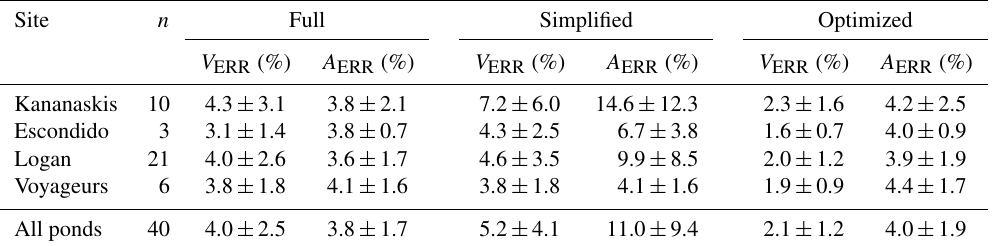
Table 3. V–A–h model performance comparisons based on the mean ( ± standard deviation) volume ( V ERR ) and area ( A ERR ) error magnitude. “ n ” is the number of ponds studied at each site. Site n Full Simplified Optimized V ERR (%) A ERR (%) V ERR (%)